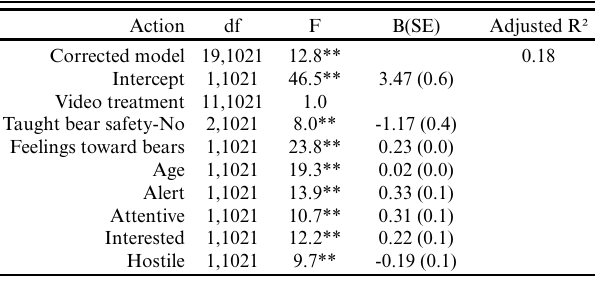
Table 3 . Univariate general linear model for the impact of previous bear safety education on an individual’s in-the-moment decision for both video treatments. Note: *p < 0.05 **p <